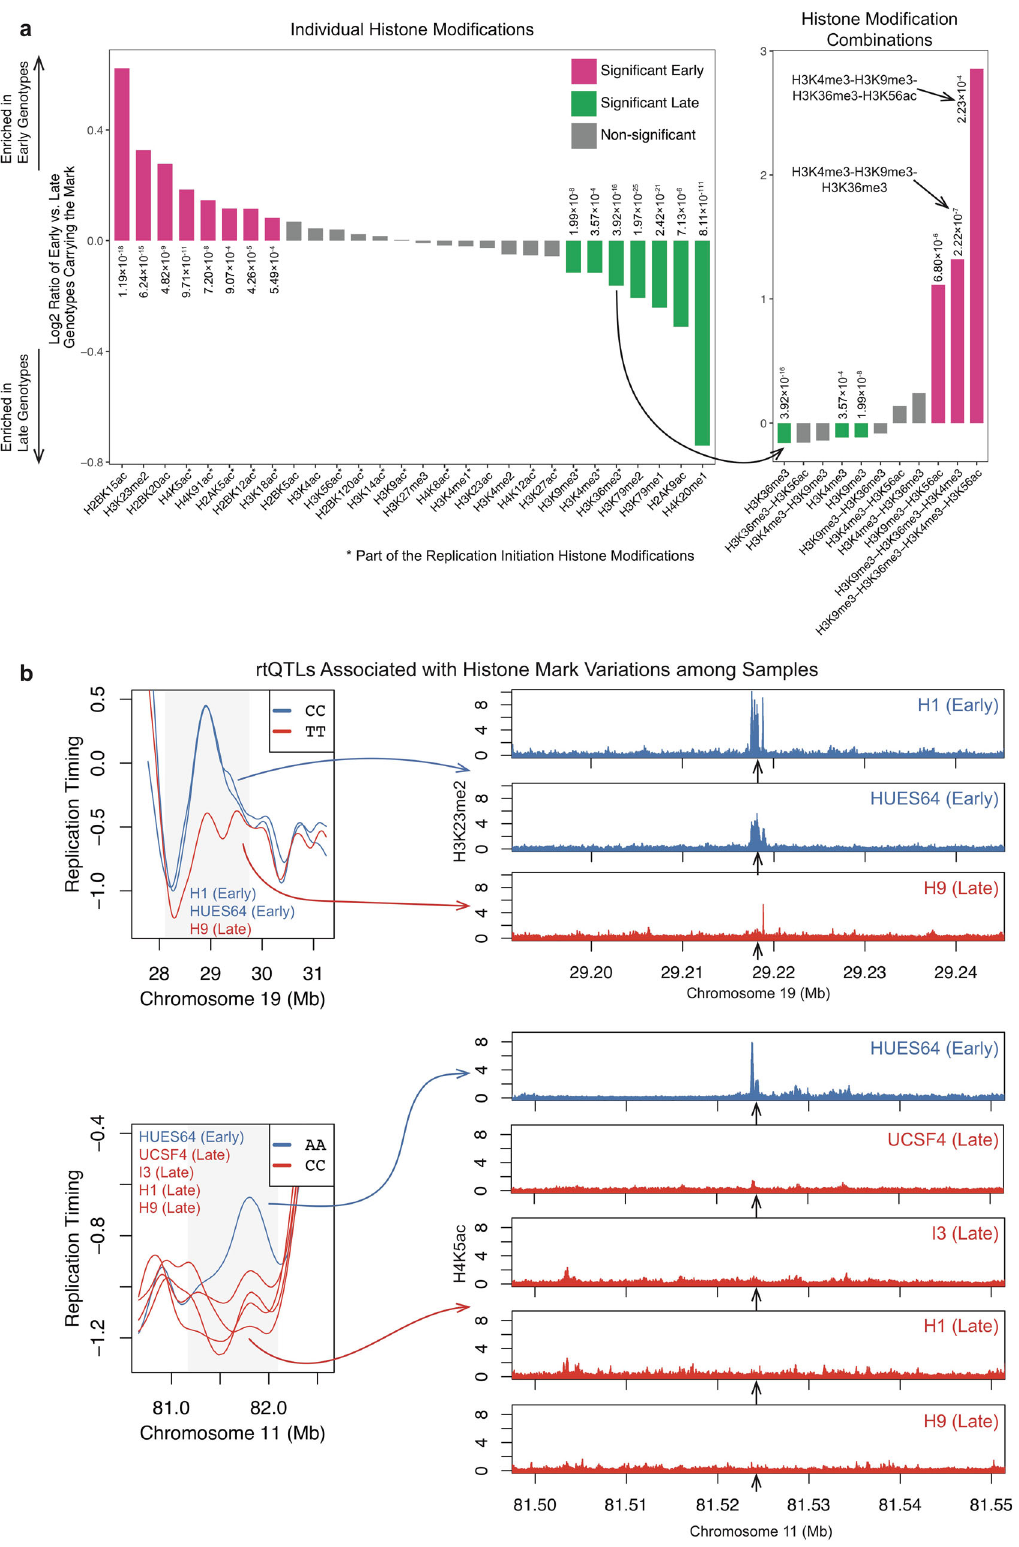
Fig. 4 Histone marks associate with DNA replication timing. a Association of rtQTL genotypes with individual (left panel) or combinations (right panel) of histone marks. Positive (negative) values indicate that individuals with early (late)-replicating genotypes are more likely to carry a histone mark at those rtQTL sites. Right panel: while individual H3 methylation marks associate with late replication, the H3K4me3-H3K9me3-H3K36me3 combination is strongly associated with early replication, and even more so when combined with H3K56ac. Note the different Y scale. b Examples of rtQTLs associated with histone mark variations. Replication timing and corresponding histone ChIP-seq tracks for individual cell lines homozygous for the early- or late- replicating alleles. Early replication correlates with the presence of the speci fi ed histone